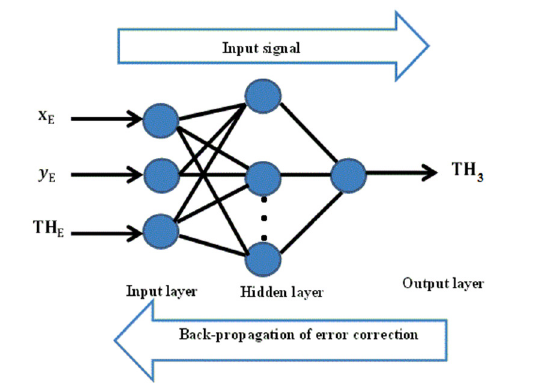
Fig. 4. BPNN structure for three-link robot of TH 2 output.